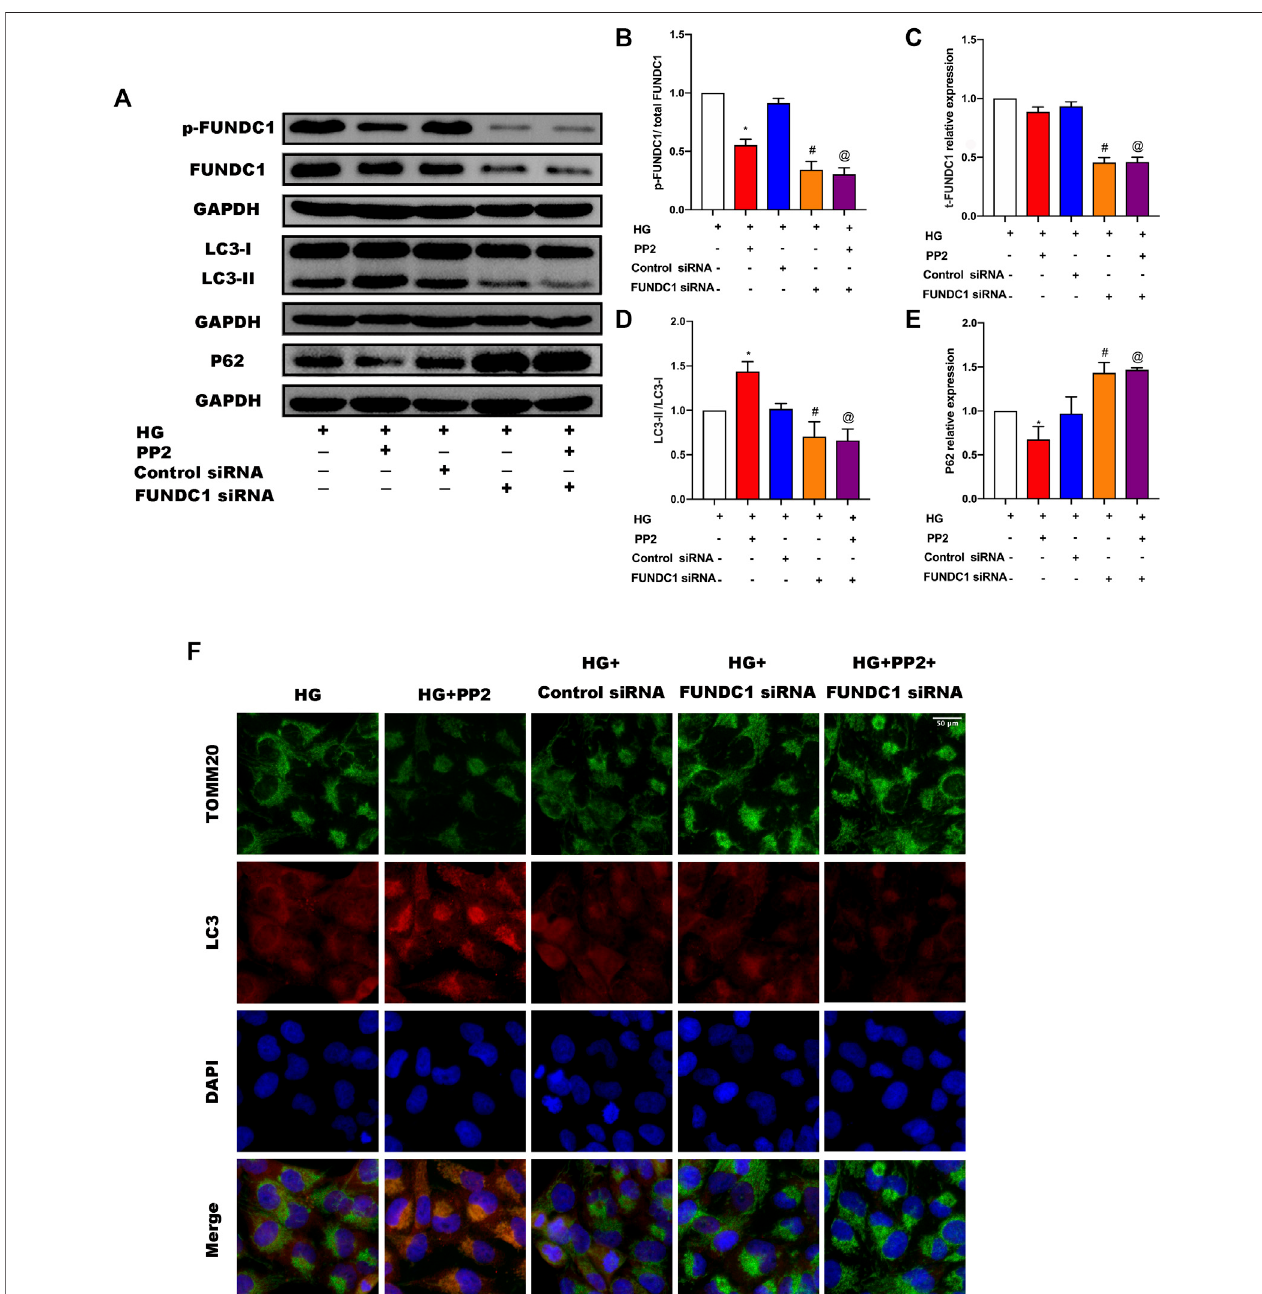
FIGURE6| Silencing ofFUNDC1 inpodocytes suppressed themitophagyinduced byPP2. (A) RepresentativeWesternblotimagesofFUNDC1, p-FUNDC,LC3, and P62 expression in podocytes after the indicated treatments. (B – E) Quanti fi cation of Western blot band intensities of the different proteins; GAPDH was used as loadingcontrol. (F) Doubleimmuno fl uorescencestainingofLC3(red)andTOMM20(green)inpodocytesaftertheindicatedtreatments(Magni fi cation,400×).Valuesare expressed as the mean ± SD, * p < 0.05 vs. HG group, # p < 0.05 vs. HG + Control siRNA group, @ p < 0.05 vs. HG + PP2 group.